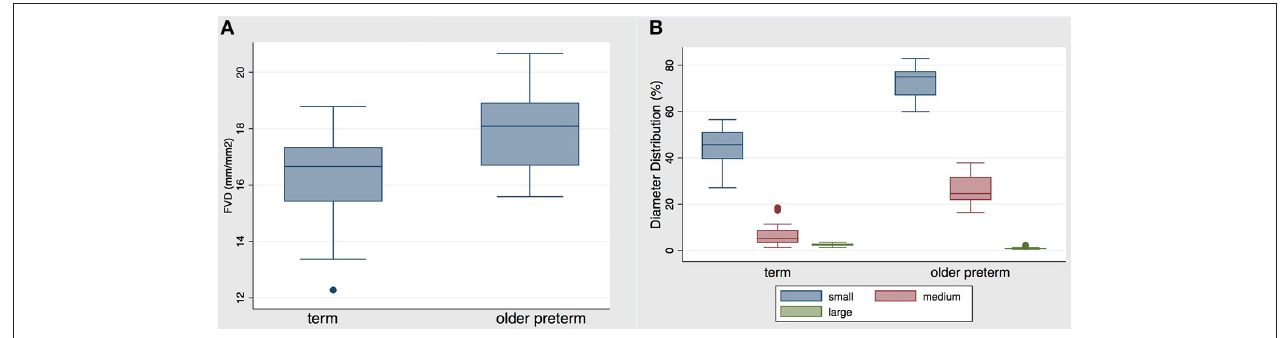
FIGURE 4 | (A) FVD and (B) distribution of diameters in the term vs. older preterm infant group. Data are presented as box-plots with median, minimal, and maximal values. FVD in the former preterm group was statistically significantly higher than in the term group ( p = 0.003). The percentage of small diameter vessels was statistically significantly higher in the preterm group, whereas the percentage of medium and large vessels was statistically significantly lower in the preterm group ( p <